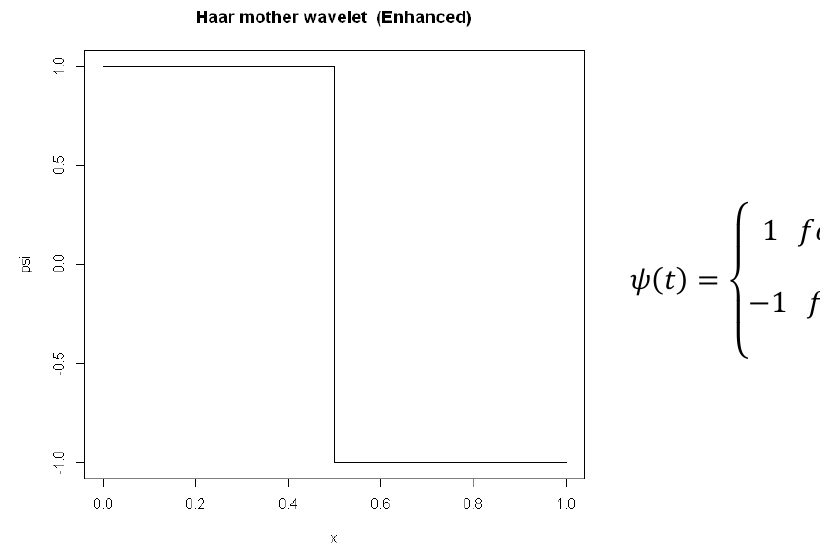
Figure 2. Wavelet function example. The Haar mother